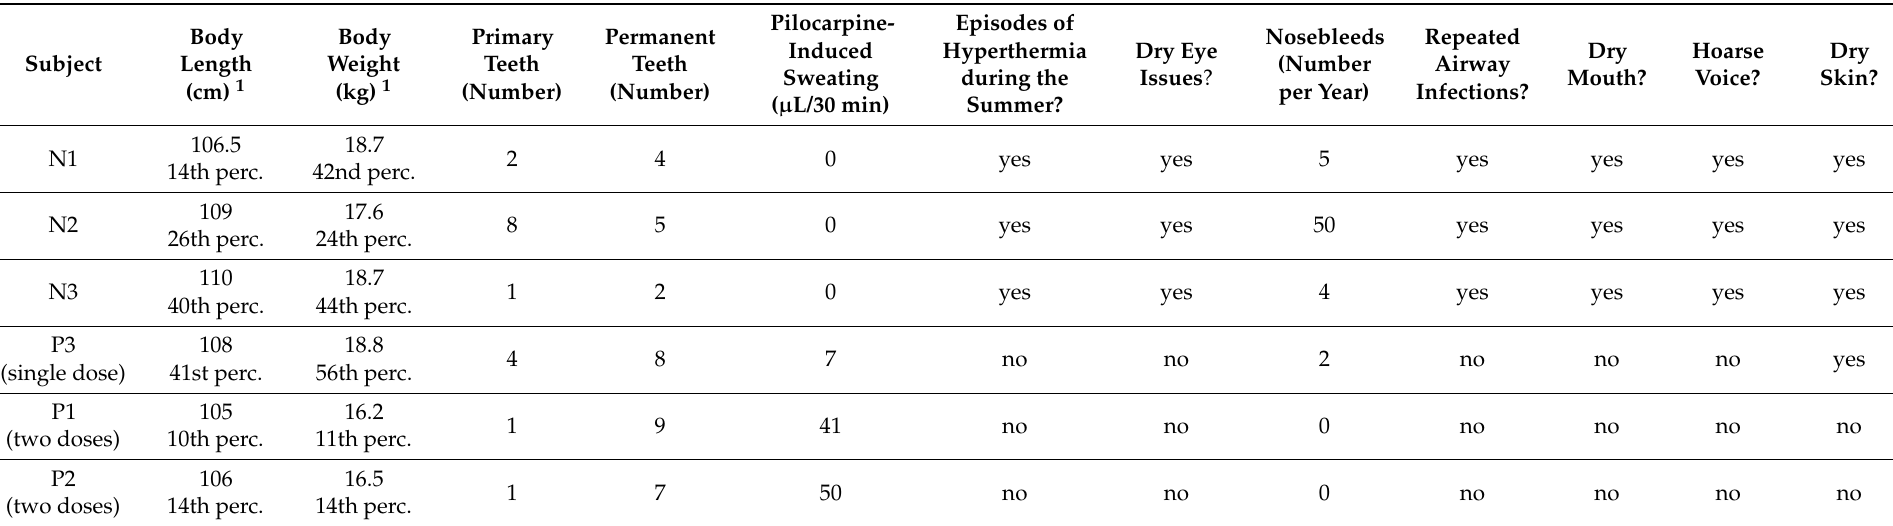
Table 2. The long-term impact of EDA1 replacement on XLHED symptoms, investigated at the age of 60 ± 3